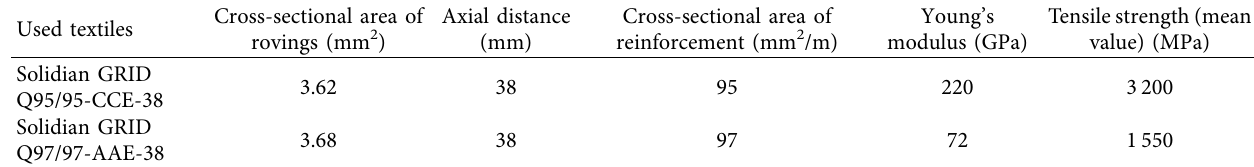
Table 1: Main properties of the used textiles (producer’s data sheet).